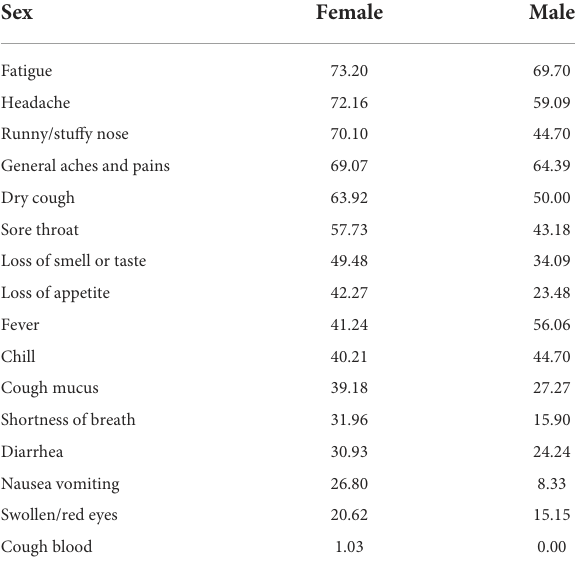
TABLE 3 Prevalence (% reporting) of symptoms in the COVID-19 + cohort for a given sex.